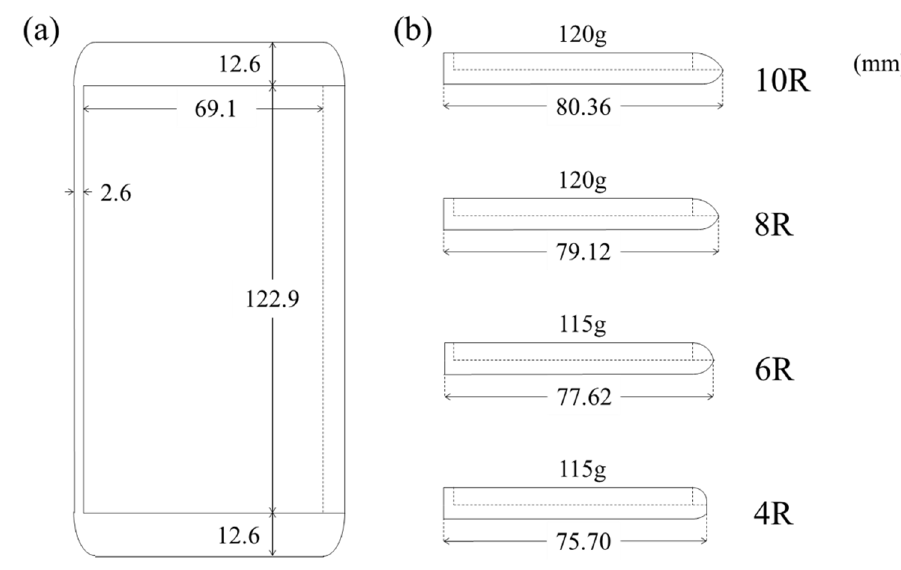
Figure 1. Dimension of samples: ( a ) Plan view. ( b ) Section view.